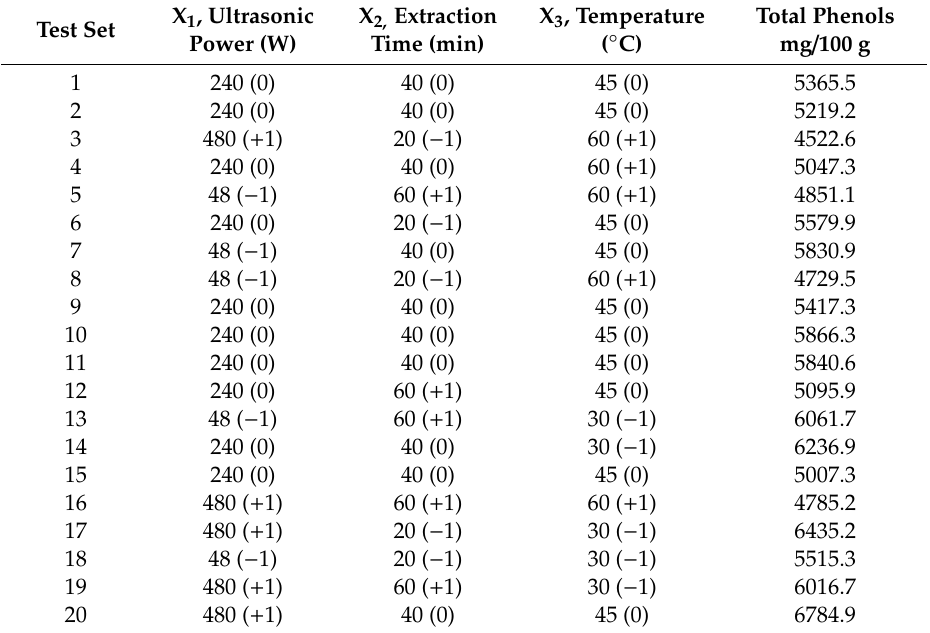
Table 2. Experimental design of three-level, three-variable central composite design for ultrasound extraction phenols from quince fruit extracts.